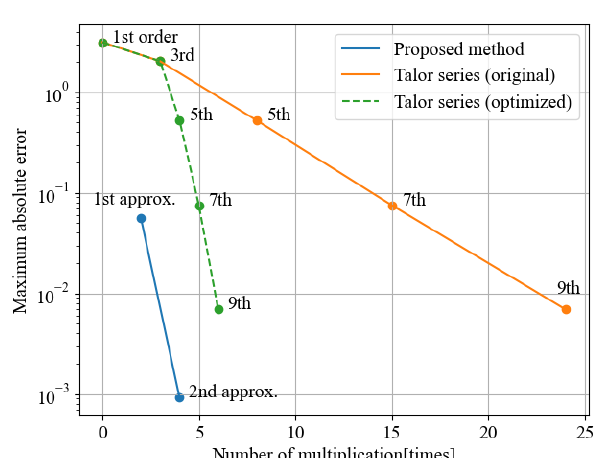
Figure 9. Comparison of maximum error and number of multiplications of sin function approximation between Taylor series and proposed method (log scale is used in vertical axis to compare error order). Table 5. Comparison summary of sin function approximation between Taylor series and proposed